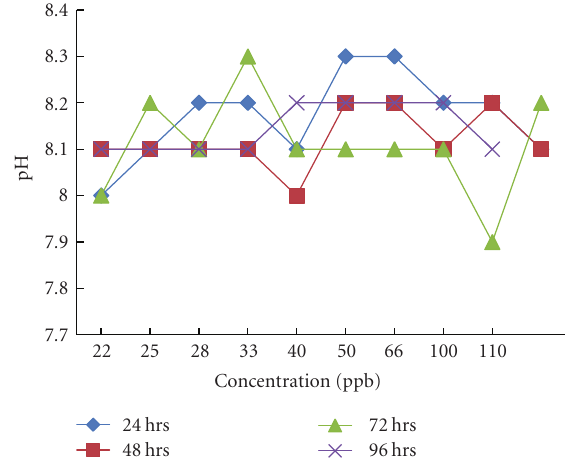
Figure 2: pH of test solution during 96-hour exposure of Clarias gariepinus of various concentrations of gammalin 20.